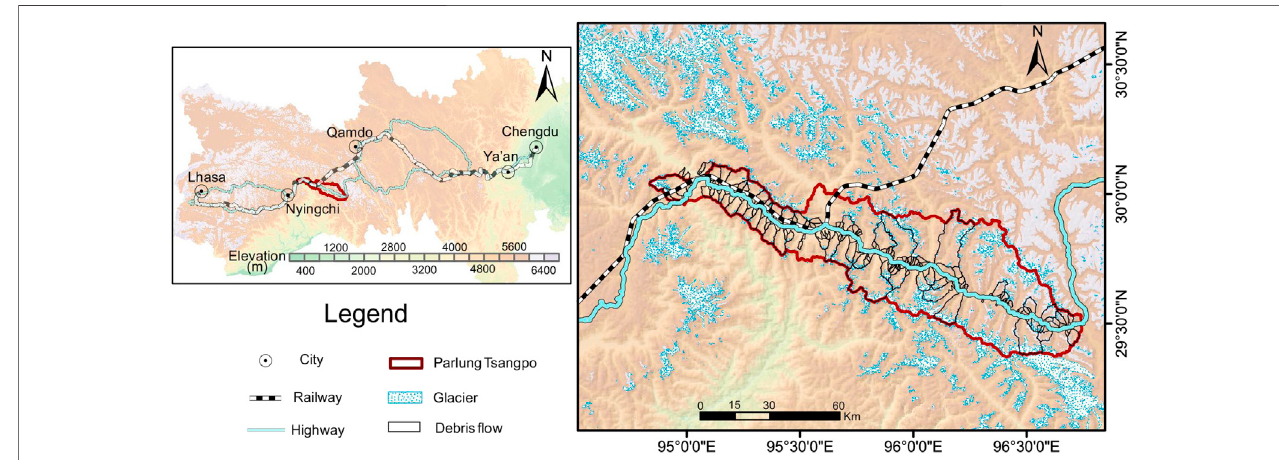
FIGURE 1 | Geographical location and characteristics of Parlung Tsangpo